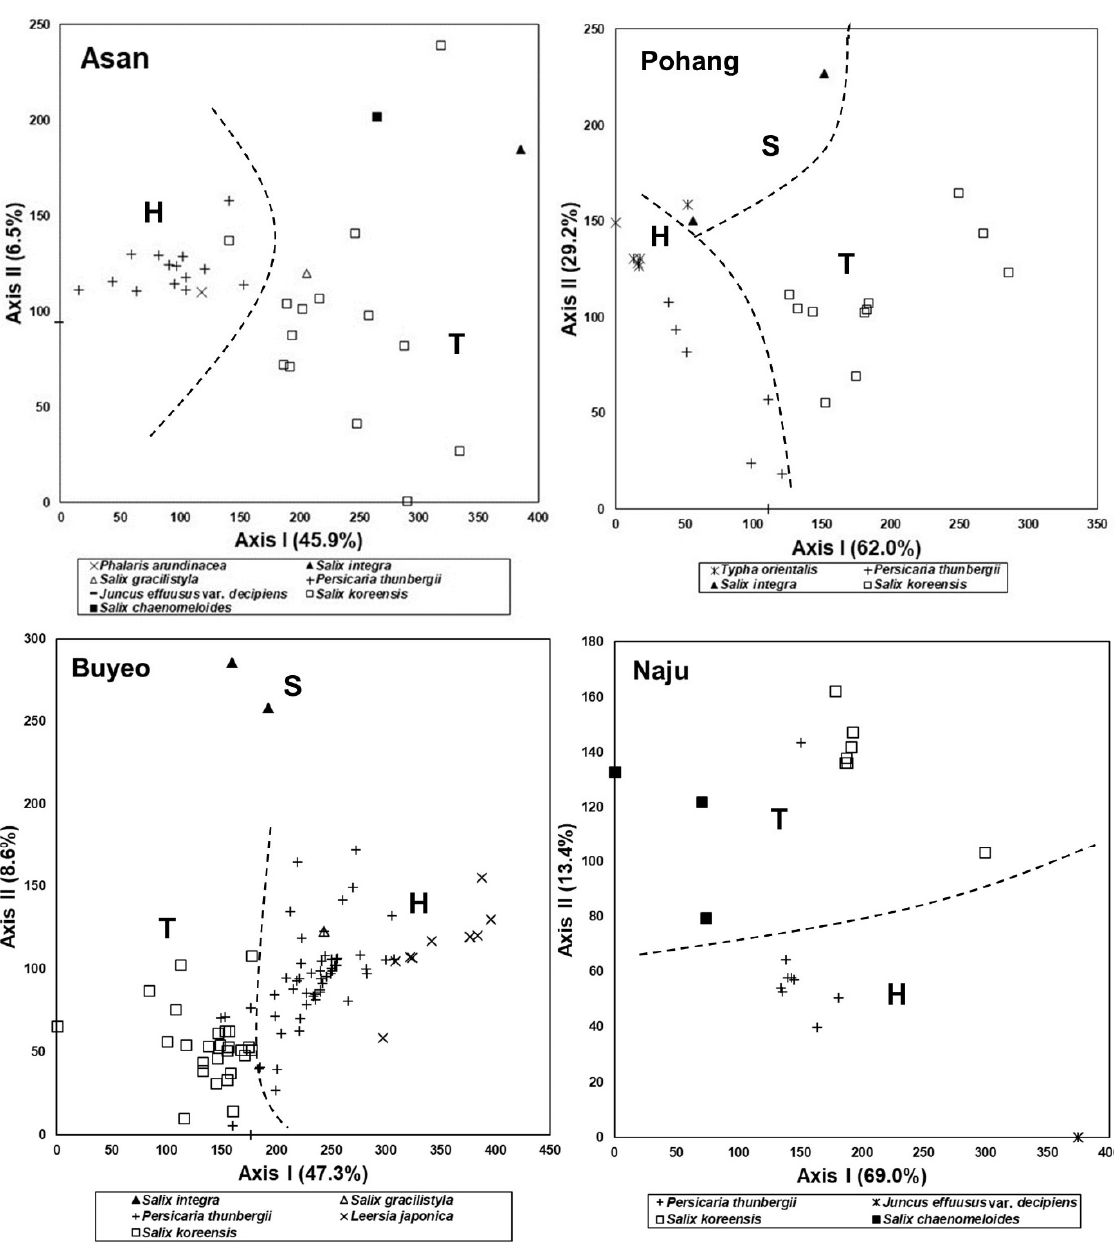
Figure 4. DCA ordination of stands based on vegetation data collected from the abandoned rice fields of eight areas selected across the whole national territory of South Korea. Stands tended to be arranged in the order of herbaceous plant (H)-, shrub (S)-, and tree (T)-dominated stands on Axis I or II. Arrangement of stands reflected successional change over years after abandonment of the rice paddy.